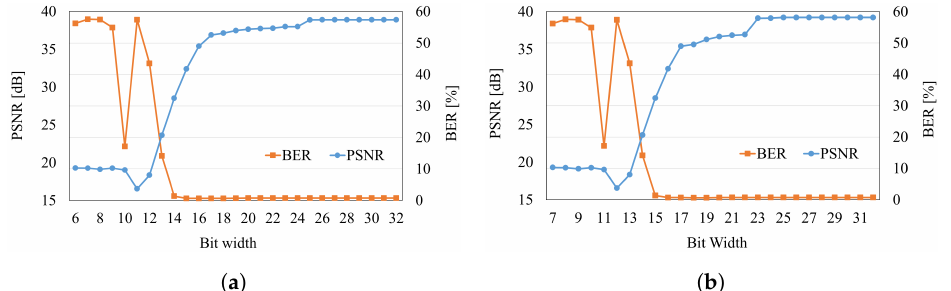
Figure 8. Precision analysis of the partial sum number system: ( a ) 4 bits for integer part, ( b ) 5 bits for integer part.